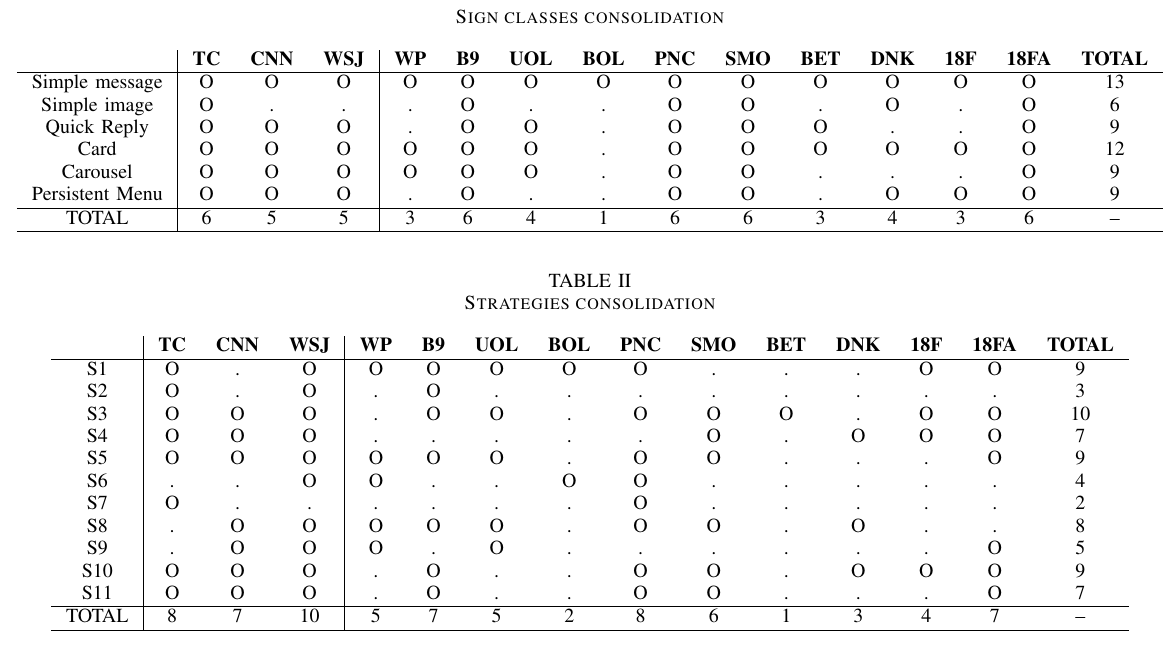
ward in the interaction. Each row indicates a different sen- tence/word, while the columns represent the chatbots, except for the last column and row that are the totals. The